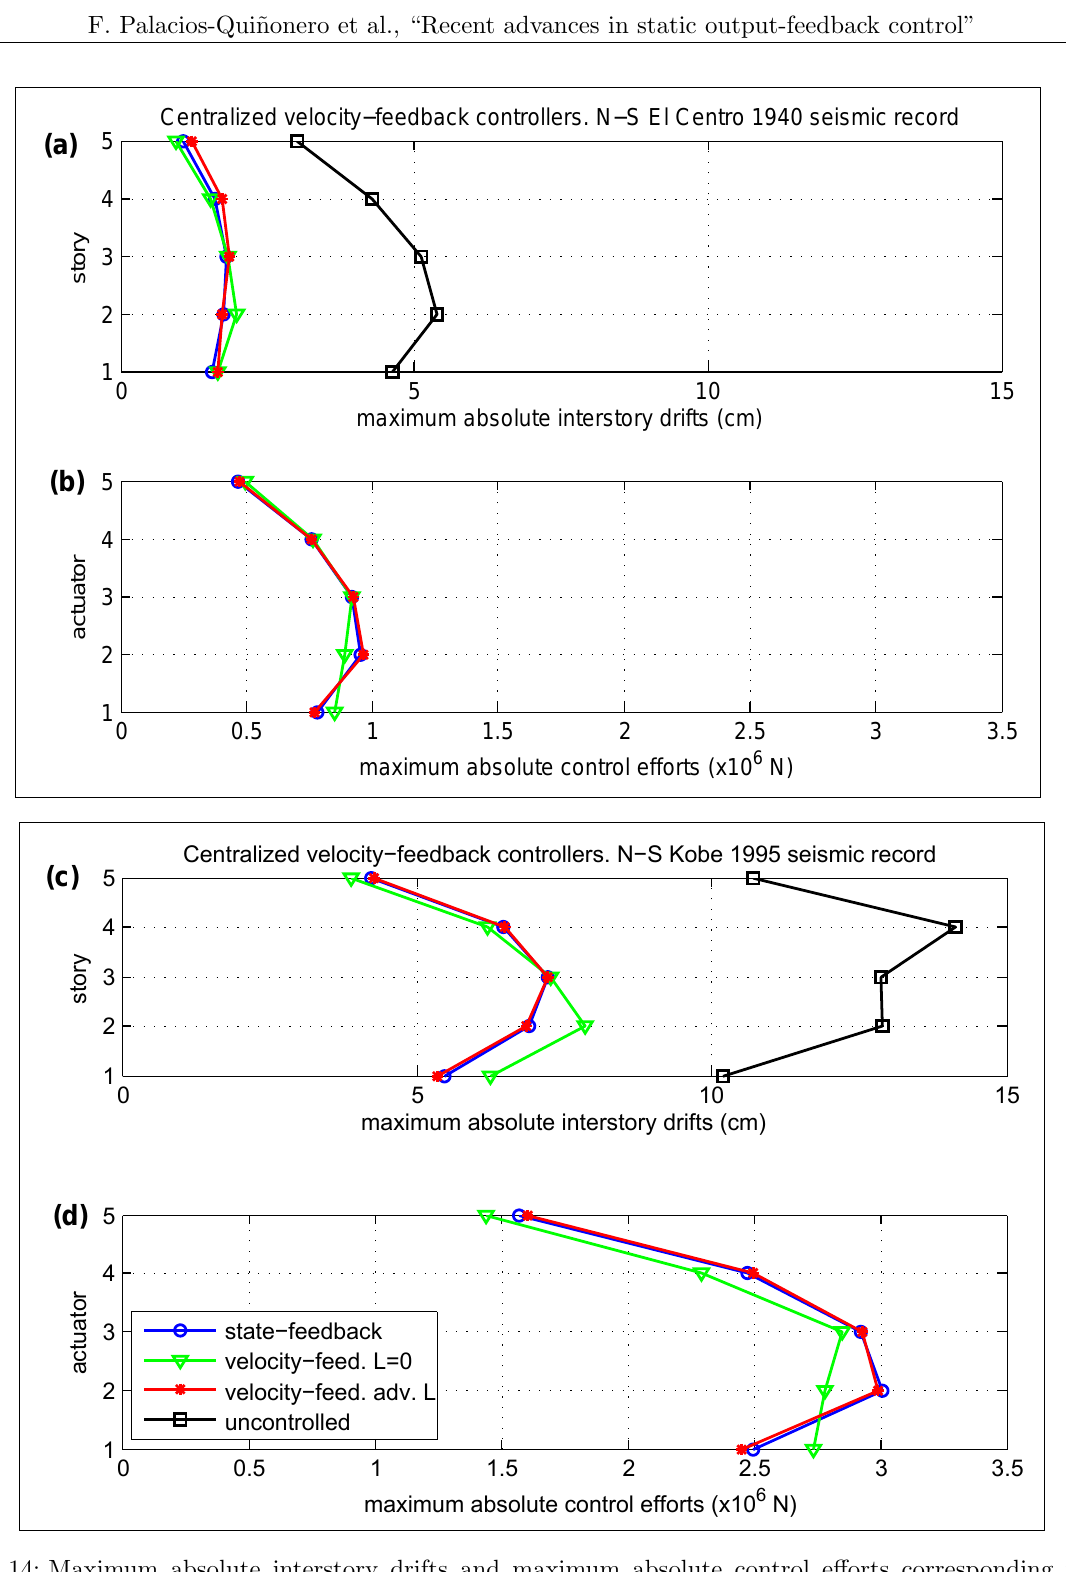
Figure 14: Maximum absolute interstory drifts and maximum absolute control efforts corresponding to the centralized velocity-feedback controllers defined by the control gain matrices (cid:98) K (green line with triangles) and (cid:101) K (red line with asterisks). The plots corresponding to the uncontrolled building (black line with rectangles) and the optimal state-feedback H ∞ controller (blue line with circles) are also included as a reference. The full scale North–South El Centro 1940 seismic record has been used as ground acceleration input to obtain the plots in Figs. (a) and (b). For the plots in Figs. (c) and (d), the full scale North–South Kobe 1995 seismic record has been taken as ground acceleration